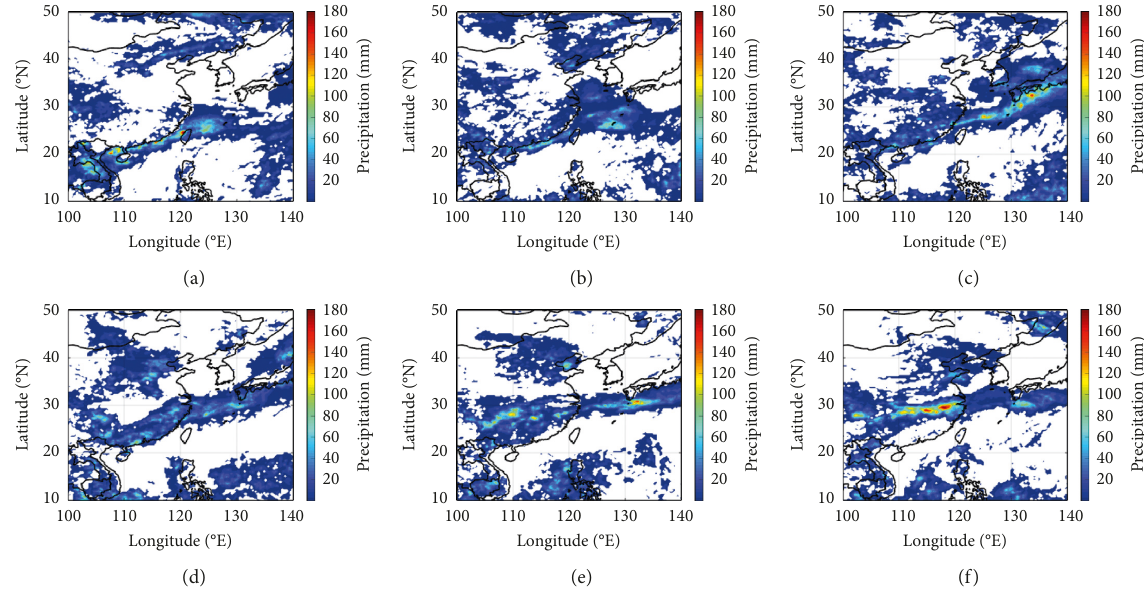
Figure 8: Maps of daily accumulated precipitation from 18 to 23 June 2017. The precipitation data were retrieved from the TRMM with a spatial resolution of 0.25 ° 0.25 ° . (a) 18 June 2017. (b) 19 June 2017. (c) 20 June 2017. (d) 21 June 2017. (e) 22 June 2017. (f) 23 June 2017. ×